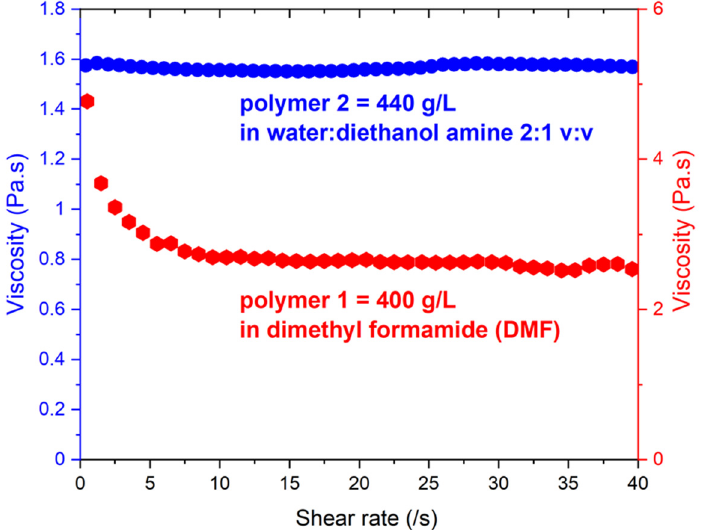
Figure 2. Viscosity of polymer solutions vs. shear rate (using polymer concentrations that correspond to electrospinning conditions, as shown in Table 1).